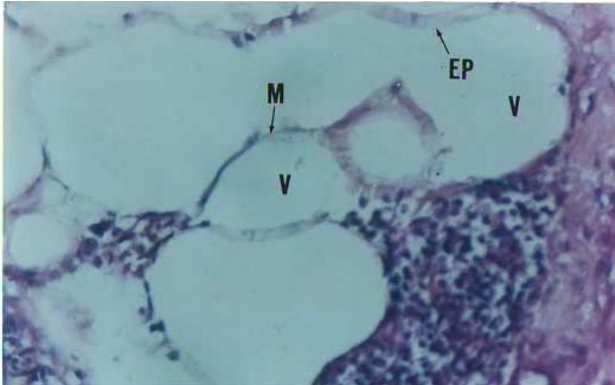
(Fig. 21): Photom ic rosc op ic illust rat es in adult geese are lined by simple cubodail epithelial cells (EP) and this epithelium is surr oud ed b y ver y thin membrane (M), these vesicles coalesce with each other.(H& E stain, 100 X)